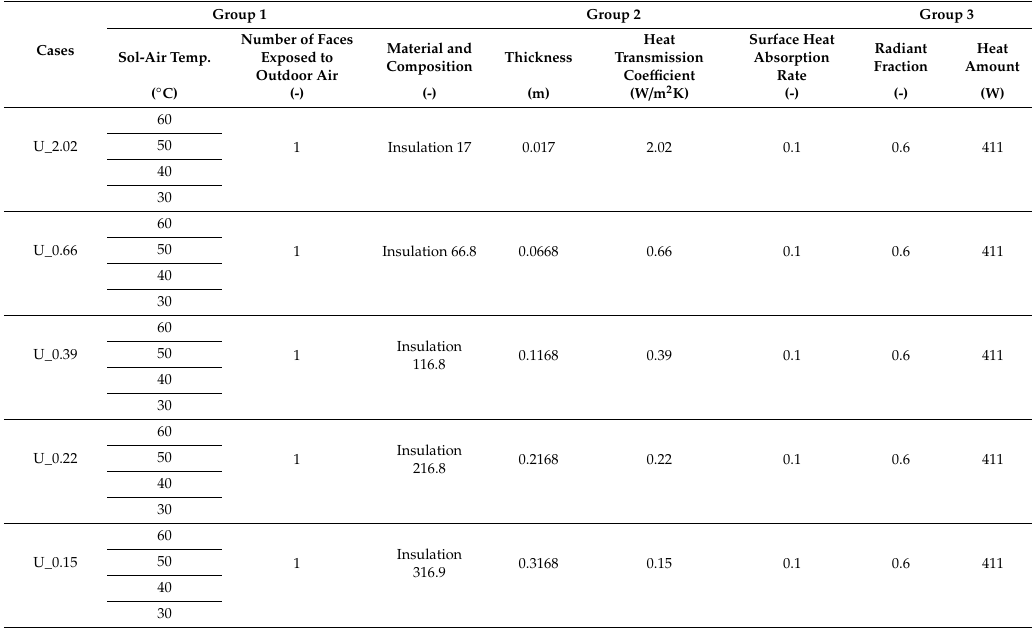
Table 10. Cases for heat transmission coe ffi cient of wall.